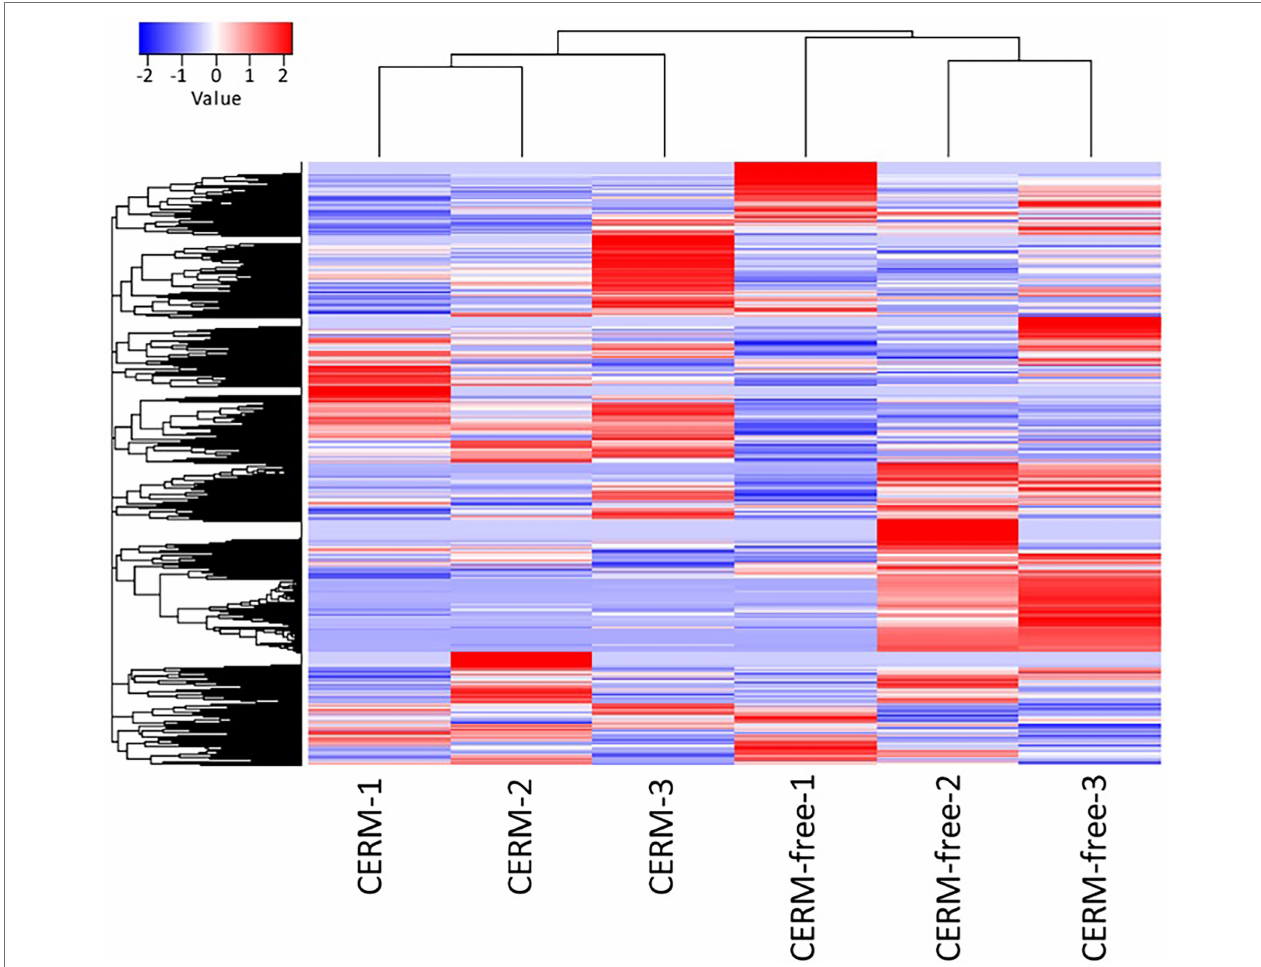
FIGURE 3 | Differentially expressed transcripts in CERM ( Coxiella endosymbiont from Rhipicephalus microplus ) and CERM-free metanymphs. Heat map of normalized TPM data for CERM and CERM-free replicates. The row Z-score color scale accounts for the Z-score deviation from the mean by standard deviation